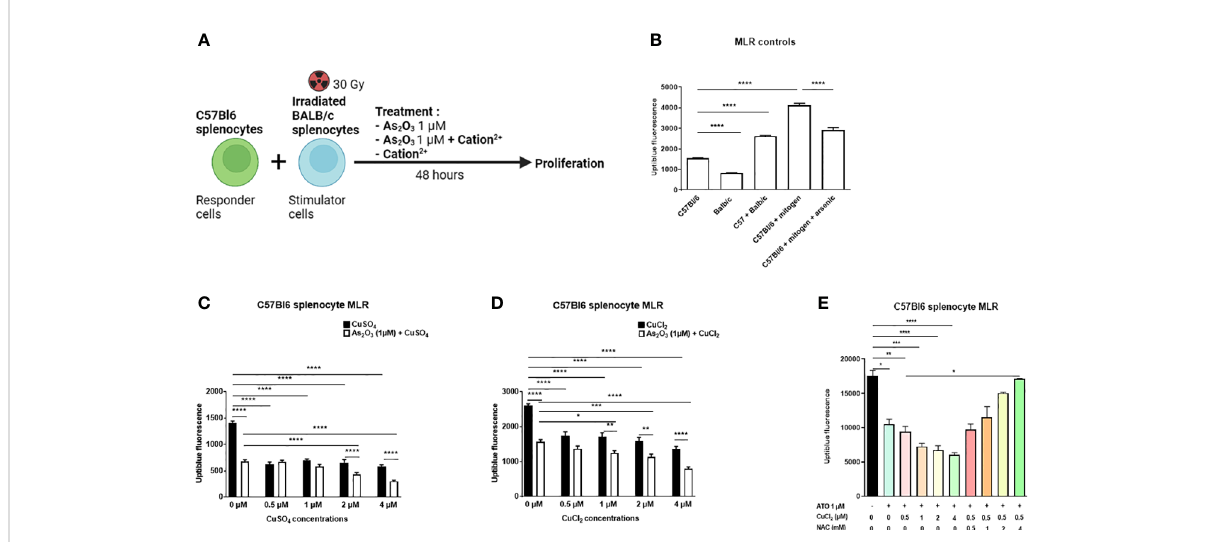
FIGURE 3 ATO and Cu 2+ decrease lymphocyte proliferation during Mixed Lymphocytes Reaction (MLR). (A) Schematic representation of the MLR. Splenocytes from C57B1/6 mice were co-cultured with previously irradiated splenocytes from BALB/c mice. The co-culture was treated for 48 hours with arsenic trioxide at 1 m M +/- the Cu 2+ . After stimulation, the proliferation of the C57Bl/6 cells was measured using the UptiBlue test. (B) UptiBlue fl uorescence analysis of lymphocyte cell proliferation after in vitro MLR. Responder cells consisted of lymphocytes derived from C57Bl/6 mice and stimulated cells consisted of irradiated lymphocytes from BALB/c mice. Cells were cultured in different conditions: C57Bl/6 cells alone, irradiated BALB/c cells alone, C57Bl/6 cells with BALB/c cells (MLR), C57Bl/6 cells with anti-CD3/CD8 antibody (mitogen) and C57Bl/6 cells with mitogen with ATO at 1 µM. (C) UptiBlue fl uorescence analysis after MLR and treatment during 48 hours with one concentration of ATO (1 µM) and with increasing concentrations of CuSO 4 (0-4 µM). (D) UptiBlue fl uorescence analysis after MLR and treatment during 48 hours with one concentration of ATO (1µM) and with increasing concentrations of CuCl 2 (0-4 µM). (E) UptiBlue fl uorescence analysis after MLR and treatment during 48 hours with one concentration of ATO (1 µM), with increasing concentrations of CuCl 2 (0-4 µM) and with or without increasing concentrations of NAC (0-4 Mm). *p <0.05; **p<0.01; ***p<0.001; ****p<0.0001. The results are the mean of 6 replicates per